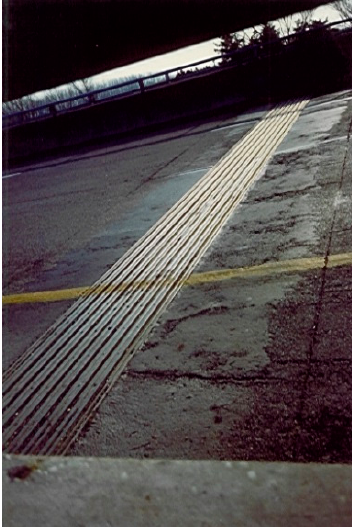
Figure 4. Pavement condition of the area surrounding the BEJ.